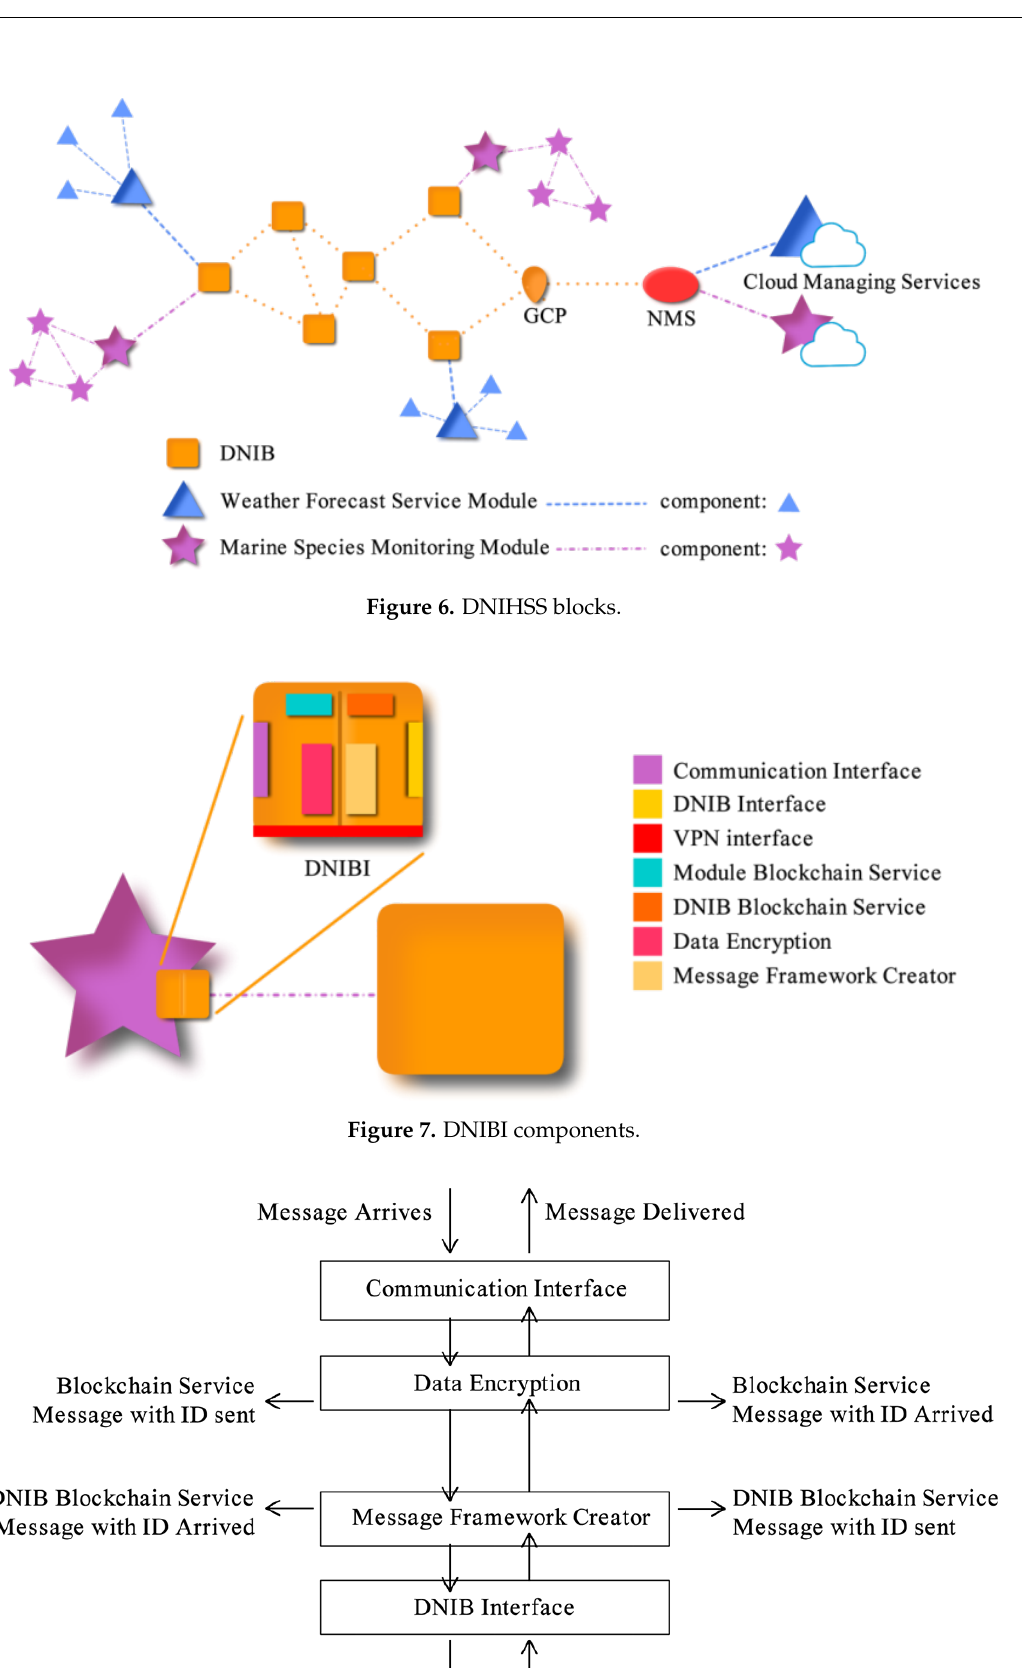
Figure 7. DNIBI components.